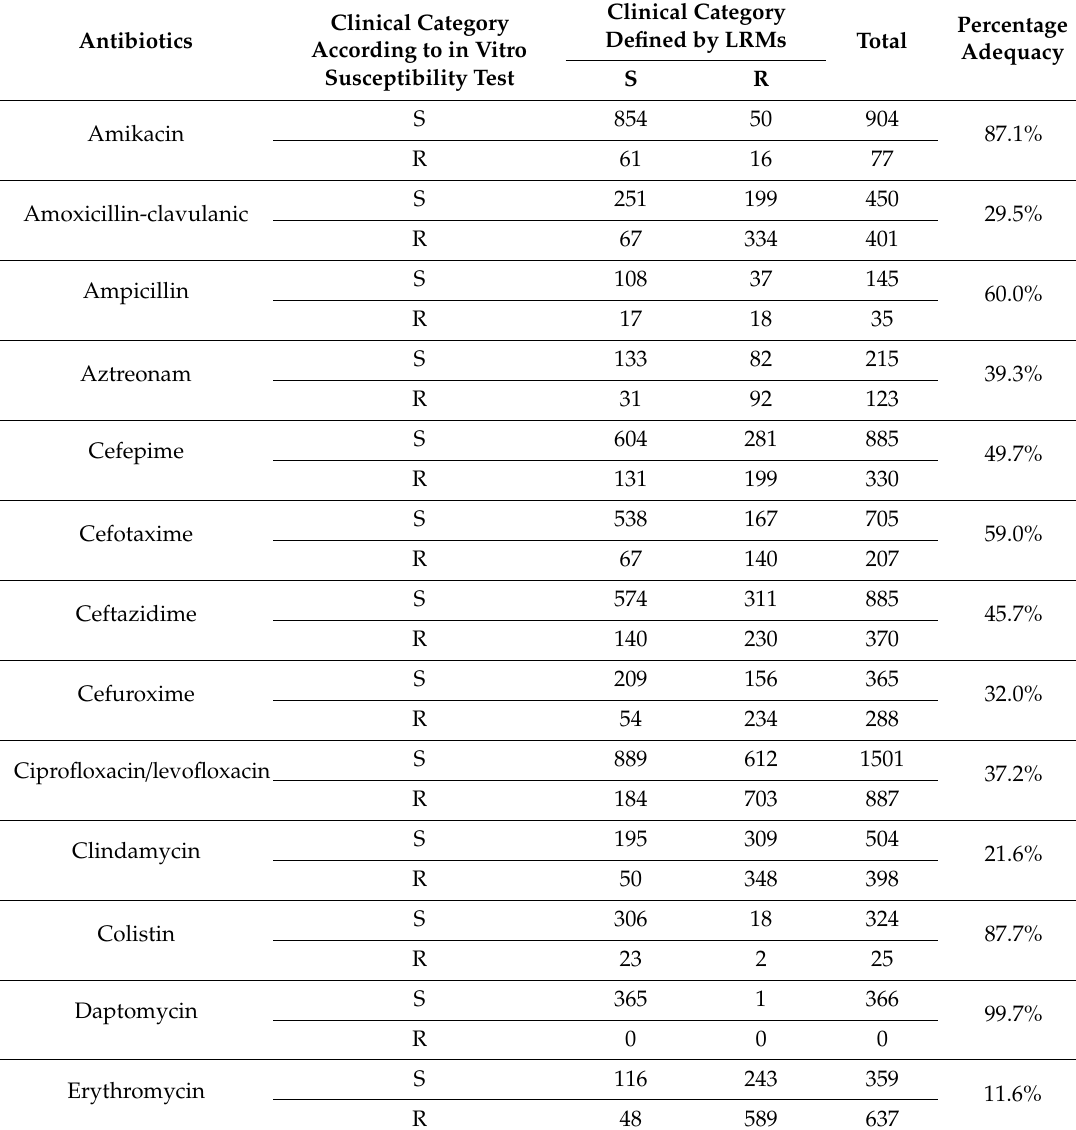
Table 3. Percentage adequacy of the empirical prescription of an antibiotic if based on LRM recommendations with reference to the actual susceptibility of isolated